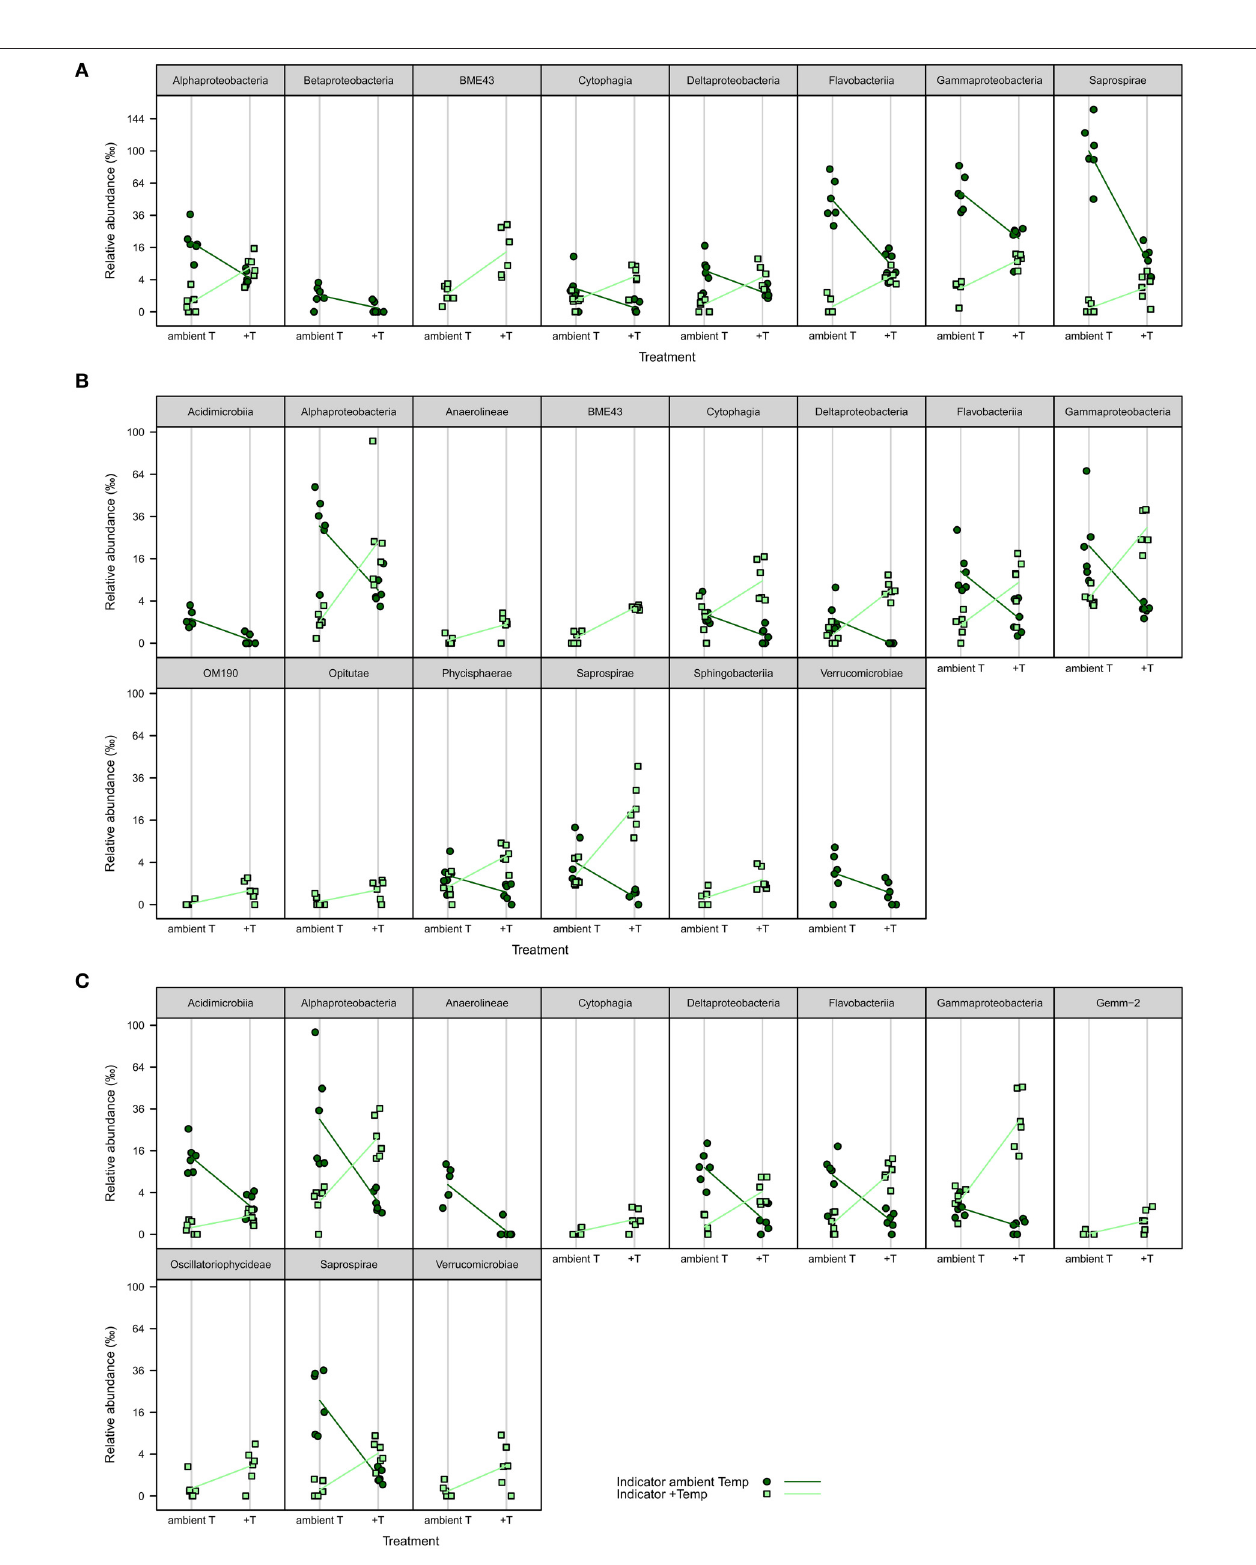
FIGURE 5 | iOTUs for temperature on Fucus mytili . Relative abundances in ‰ of single iOTUs for ambient (dark green circles) and increased (light green squares) temperature on F. mytili in (A) week 4, (B) week 8, and (C) week 11 summarized at class level ( q ≤ 0.05) per sample ( n = 6). Lines connect the mean relative abundances between both treatment levels. + T, increased temperature